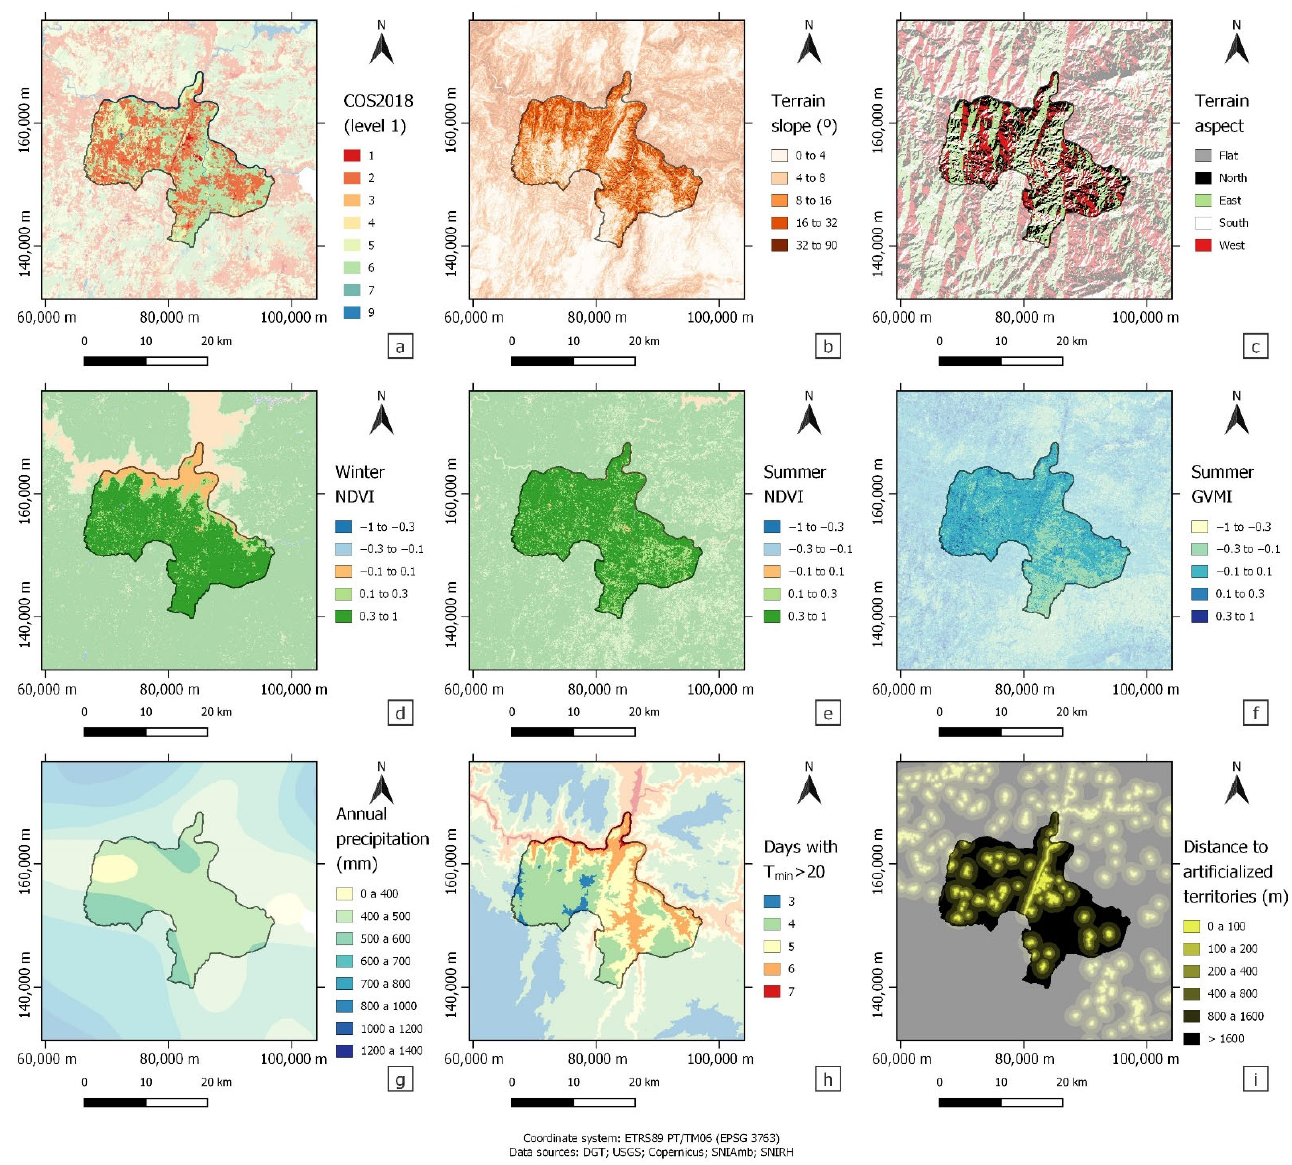
Figure 3. Environmental variables analyzed in the study: land use ( a ); slope ( b ); aspect ( c ); NDVI ( d , e ); GVMI ( f ); precipitation ( g ); days with minimum temperature >20 °C ( h ); distance to artificialized territories ( i ). All geographical data were referenced in the European Terrestrial Reference System Portugal Transverse Mercator 2006 (ETRS89 PT/TM06) coordinate system, and raster information was all set to 30 m of spatial resolution, in order to match to the available altimetric information.